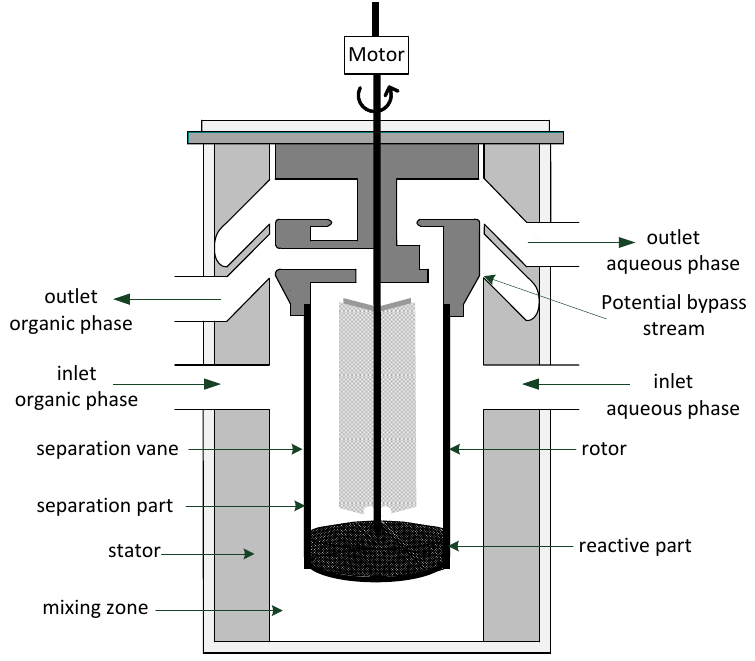
Figure 2. Scheme of a reactive extraction centrifuge (REC).